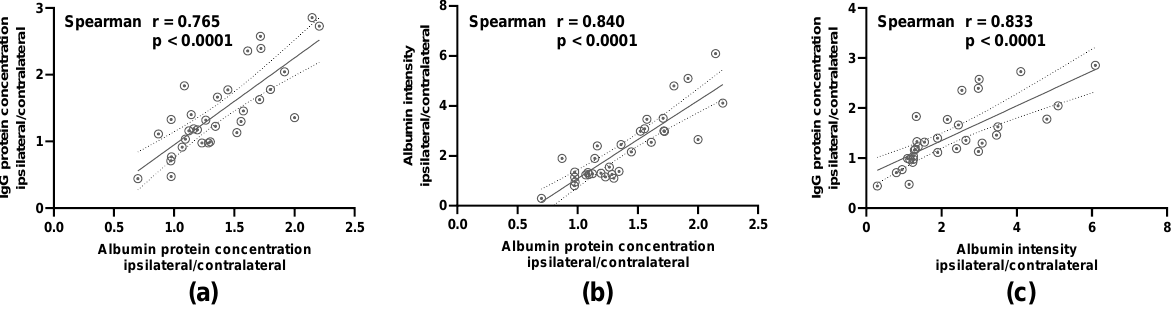
Figure 1. The outcomes of the three different methods to evaluate the blood brain barrier (BBB) disruption—IgG Western blot (WB), albumin WB and albumin intensity measurement (AIM)—correlate significantly. Pearson’s correlation analysis was performed to analyze the correlation between ( a ) the IgG protein concentration and the albumin protein concentration, ( b ) the immunohistochemically determined albumin intensity and the albumin protein concentration as well as ( c ) the IgG protein concentration and the immunohistochemically determined albumin intensity. The samples were sourced out of the penumbra region of the ipsilesional hemispheres as well as the corresponding contralesional brain regions. The reciprocal correlation between the three different methods was highly significant ( n = 32).